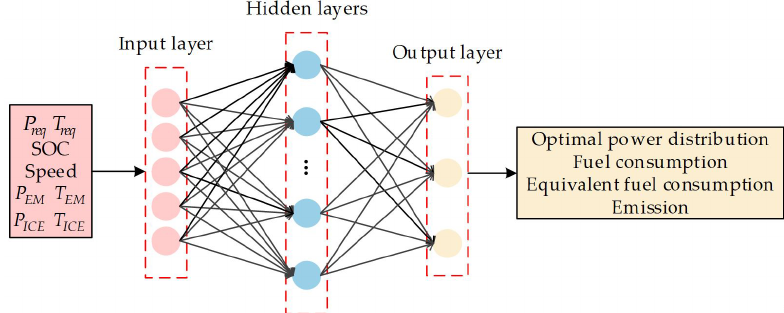
Figure 13. The control structure diagram of an NN-based EMS. Table 14. Summary of exemplary works on the NN-based EMS